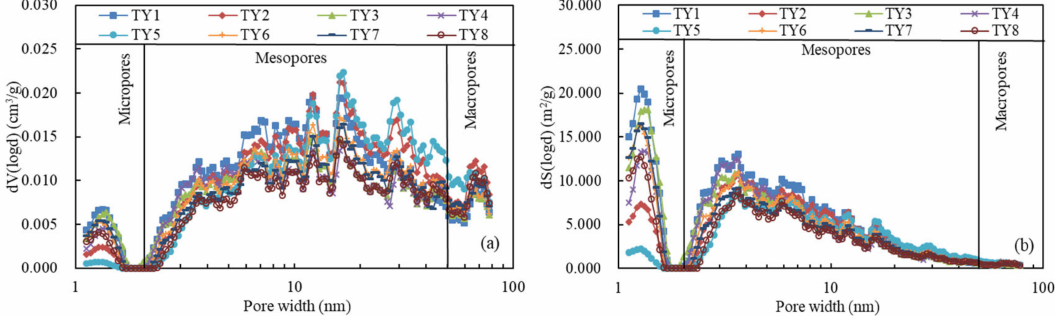
Figure 3. Pore volume ( a ) and pore surface area ( b ) distribution vs pore